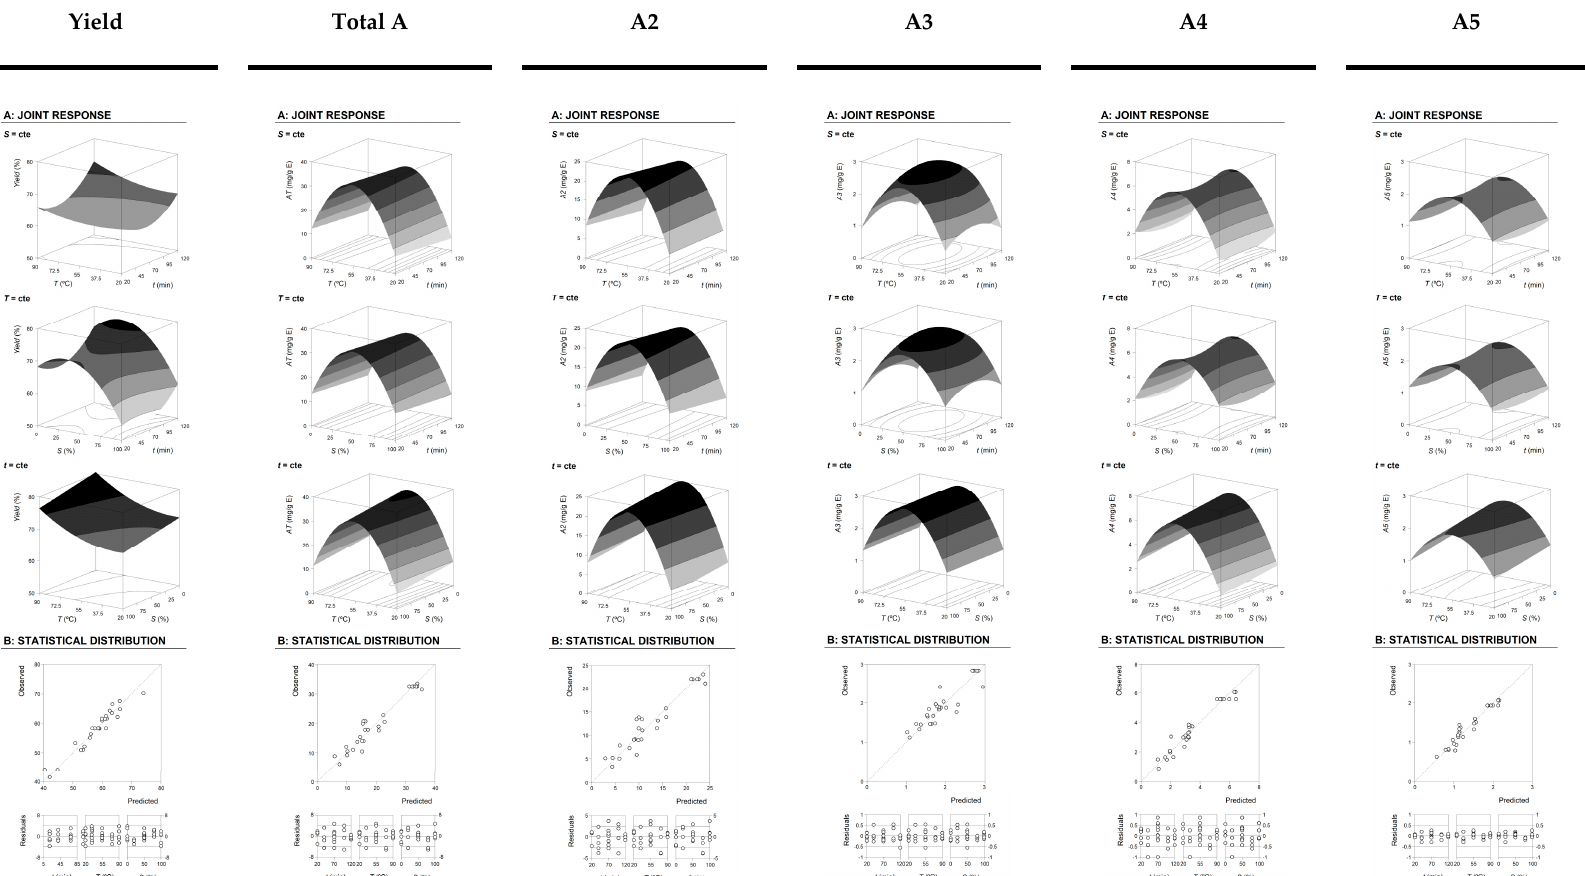
Figure 1. Shows the HAE graphical results for the extraction yield of the extracted (%) material obtained, the total anthocyanin content (AT, mg AT / g E), the major anthocyanin compound detected (A2, mg A2 / g E) and three minor anthocyanin compounds detected (A3 to A5, in mg / g E). Each figure is divided in two parts. Part A : Shows the graphical analysis by net surfaces that represents the 3D response surface predicted with the second order polynomial of Equation (1). The binary actions between variables are presented when the excluded variable is positioned at the individual optimum (Table 1B2). The experimental design and results are described in Table 1 A . Part B : To illustrate the goodness of fit, two basic graphical statistic criteria are used. The first one is the ability to simulate the changes of the response Molecules 2019 , 24 , x; doi: between the predicted and observed data; and the second one is the residual distribution as a function of each of the